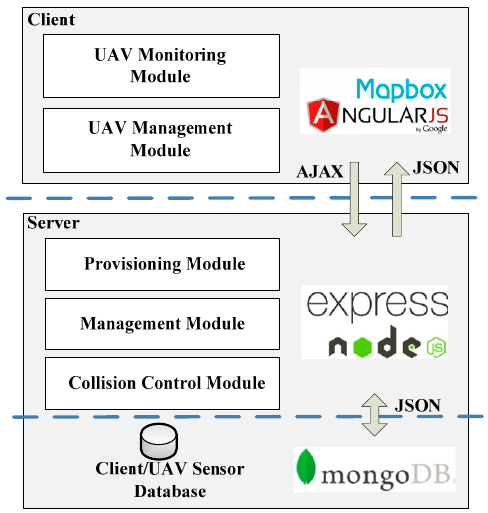
Figure 5. Development design of UAV Flight Tracker.